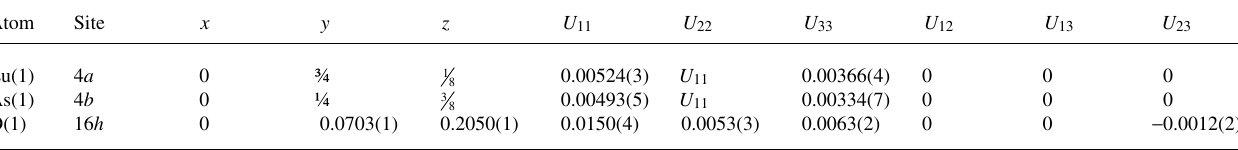
Table 2. Atomic coordinates and displacement parameters (in Å 2 )